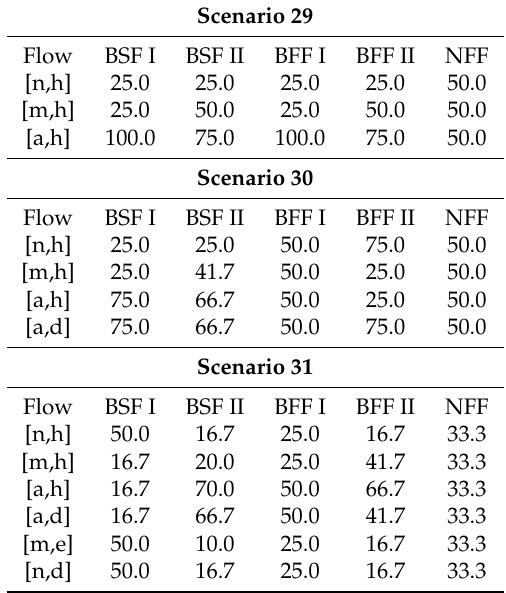
Table 9. Flow set and LP results for the flows’ end-to-end throughput for scenarios 29 to 31 described in Figure 20. All values in